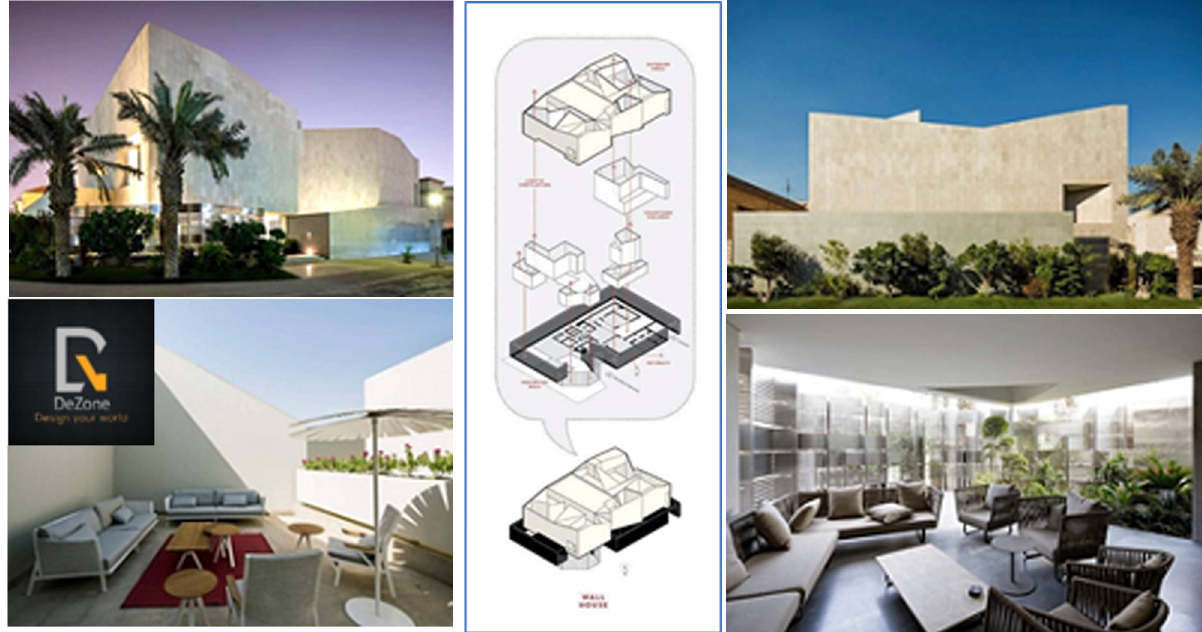
Fig. 11. Good example of using court-yard type of houses in harsh climate like in Kuwait by DeZone: